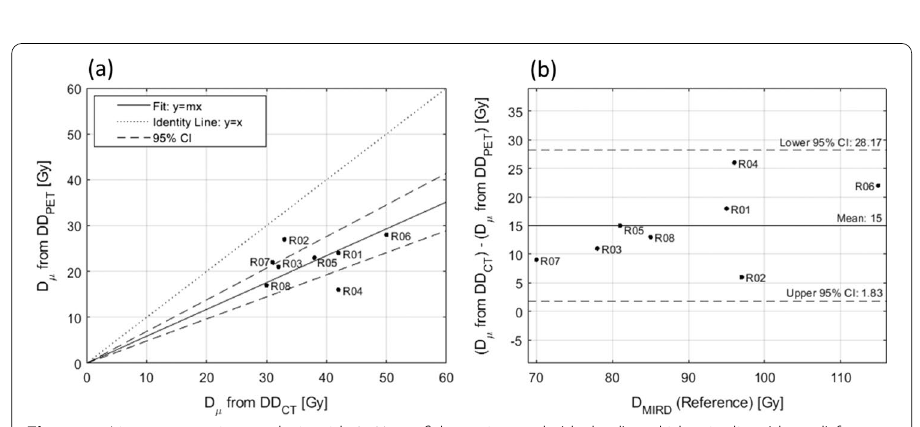
Fig. 11 a Linear regression analysis with 95% confidence intervals (dashed) and identity line (dotted) for the mean dose D µ in the CT-based dose distribution DD CT and in the PET-based dose distribution DD PET . b Bland–Altman analysis with 95% confidence intervals